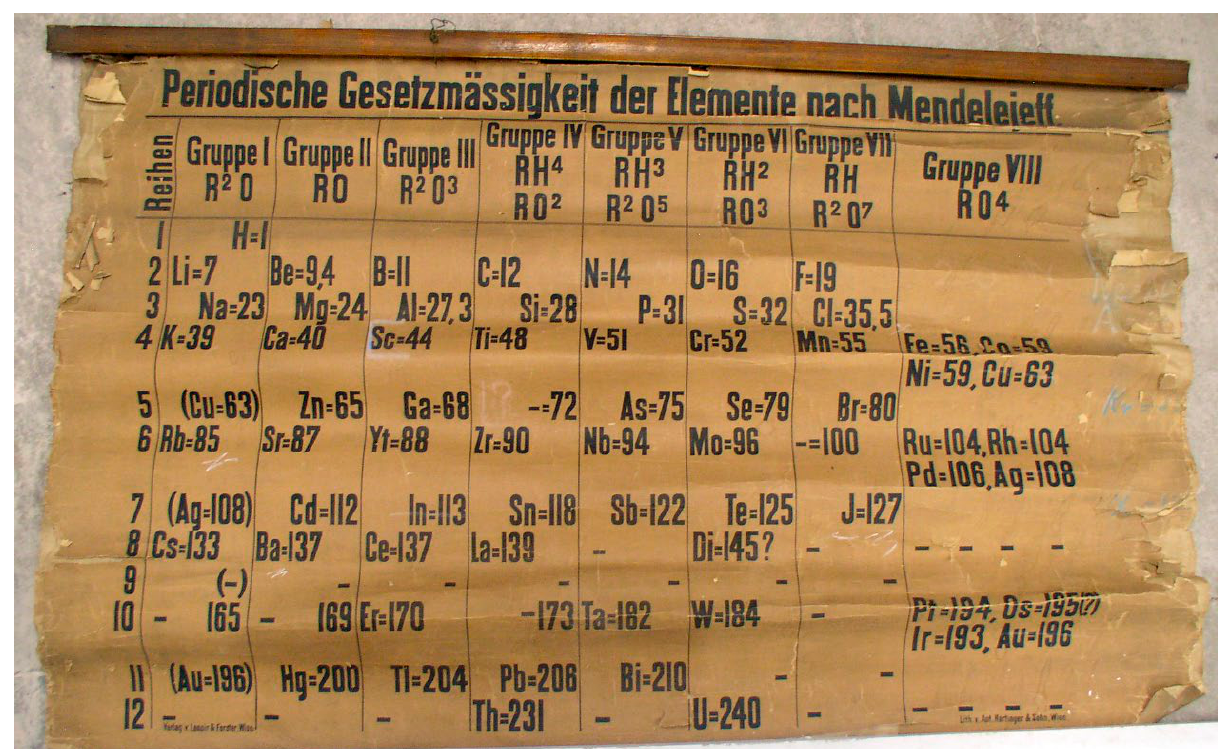
Figure 1. The St Andrews Periodic Table Wallchart as discovered. R. Alan Aitken,